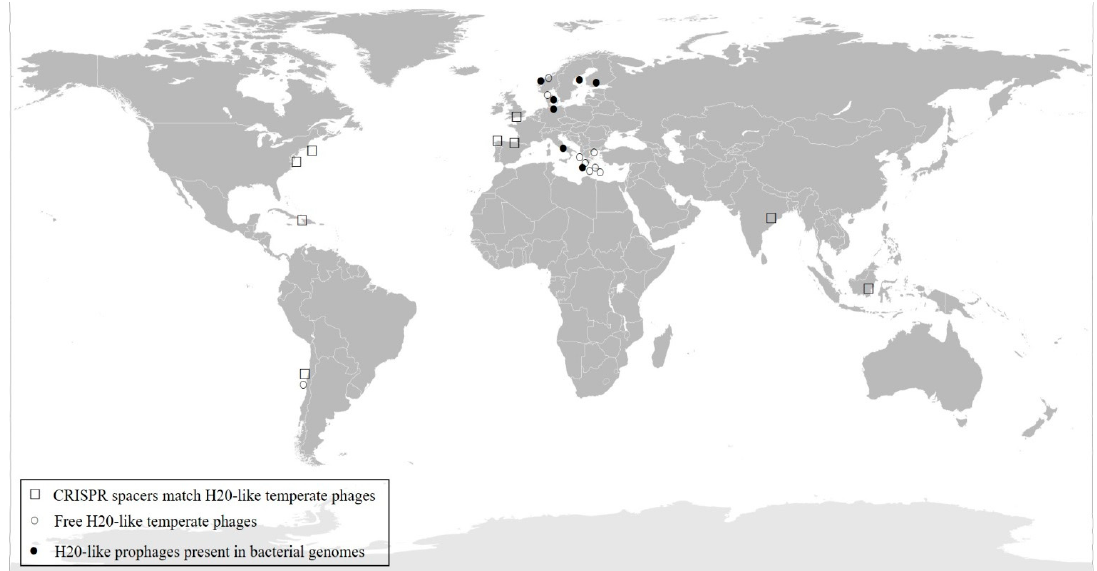
Figure 6. Distribution of H20 ‐ like phages on a global scale. The presence of the phage in the different locations was confirmed by: (a) isolating them as free phages from the environment ( ○ ); (b) bioinformatic detection of their presence as prophages in the bacterial host genomes ( ● ); and (c) high similarity matches of the temperate phages with CRISPR spacers in the Vibrio genus ( □ ).